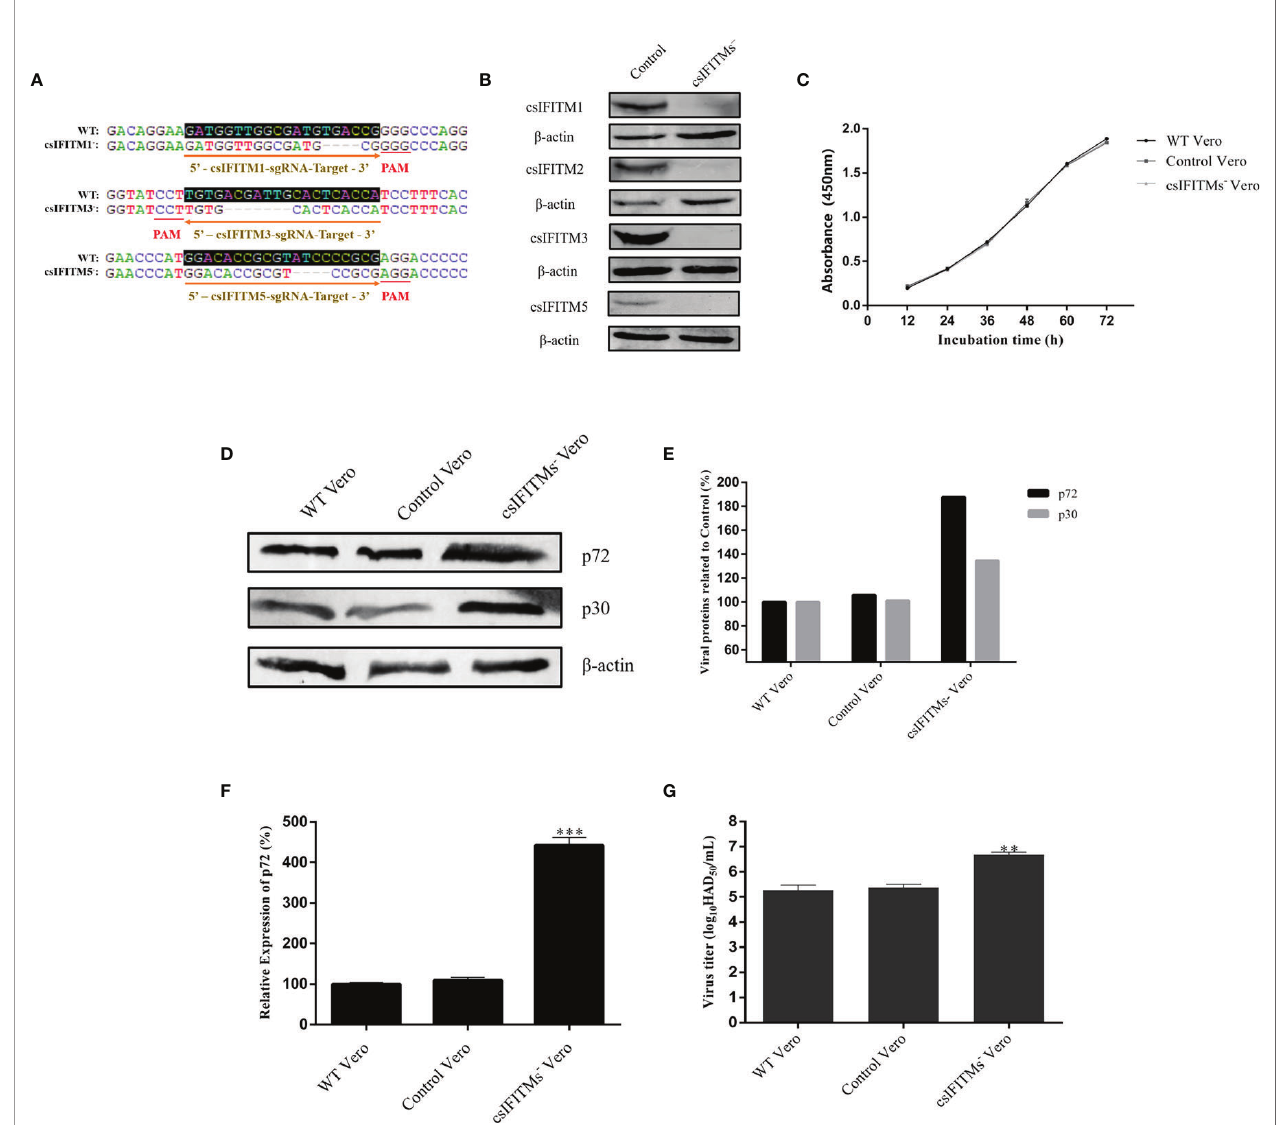
FIGURE 5 | Generation and validation of csIFITM knockout Vero cell lines. (A) Three different sgRNA targeting sites and the result of sanger sequencing with WT and csIFITMs − Vero cells. (B) Expression of endogenous csIFITMs was detected by western blotting with b -actin used as a control. (C) Proliferation of csIFITMs − , control, and untreated Vero cells were detected by the CCK-8 Cell Counting method. The csIFITMs − , control, and untreated Vero cells were infected with 0.1 MOI of ASFV; (D, E) the virus replication levels of ASFV were determined by western blotting at 36 hpi, and band densitometry for each protein was determined, and the density quantitative ratios of each viral or SwIFITM protein and b -actin were calculated, ratio of SwIFITM protein and b -actin served as a control; (F) the expression levels of p72 protein were detected by RT-qPCR with b -actin used as a control at 36 hpi; (G) the viral titration of progeny virus was tested in HAD assay. Samples were analyzed in triplicate, and three independent experiments were performed. ** p < 0.01; *** p <0.001 vs empty vector control group. Error bars indicate standard